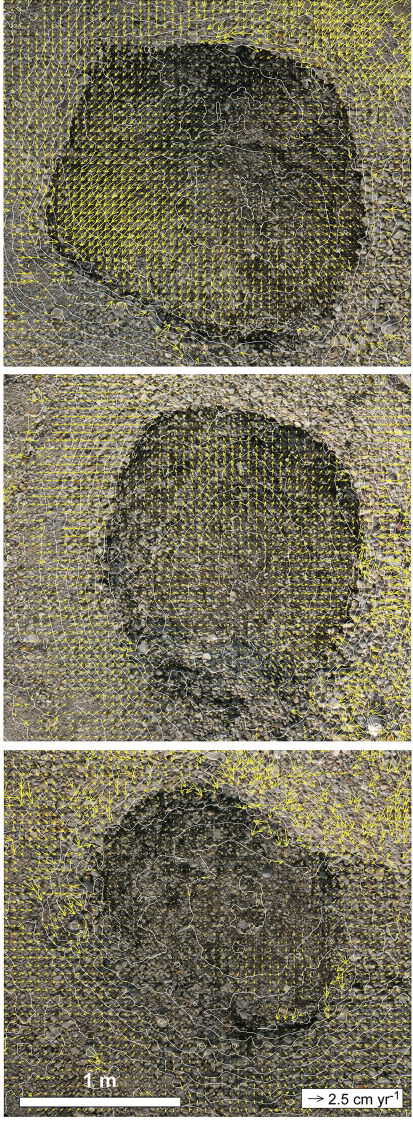
Figure 8. Horizontal surface displacements 2007–2010 on all three circles. Chaotic vectors or groups of vectors are typically caused by individual stones that slide or tip, but could in some cases also be mismatches. Measurements with very low correlation coefficients have been removed. Linear vector scale with maximum vector mag- nitude of 2.5cmyr − 1 . See Supplement for animated GIFs of the 2007 and 2010 orthoimages.